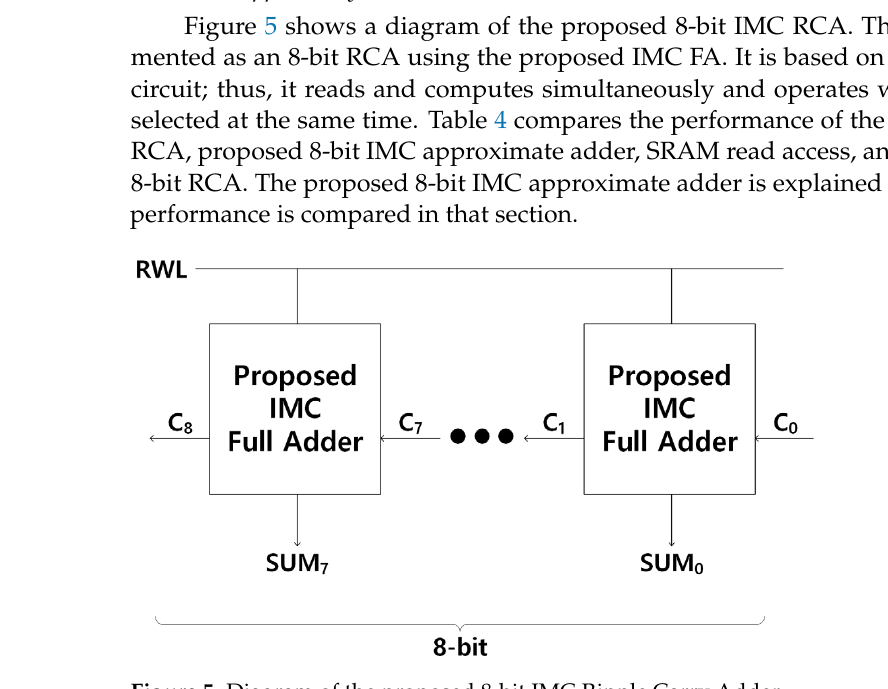
Table 4. Comparison of the performance and energy consumption in different 8 ‐ bit Ripple Carry Adders.